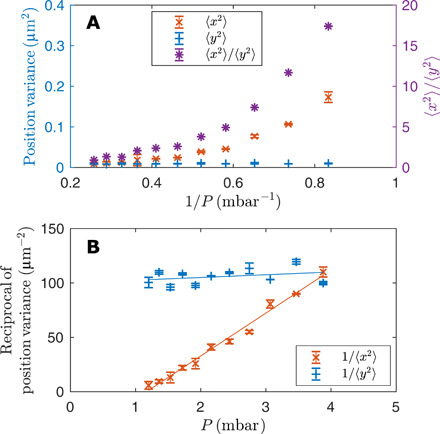
Experimentally measured position variance and its reciprocal of a vaterite microsphere.(A) Position variance in both x and y directions (left axis) and the relative energy in the x motion (right axis) at different gas pressures P. 〈x2〉 increases with decreasing P toward 1 mbar, whereas 〈y2〉 remains at room temperature. (B) The same data as (A), replotted as the reciprocal of the variance versus pressure to show the scaling behavior as the critical viscosity and pressure are approached.